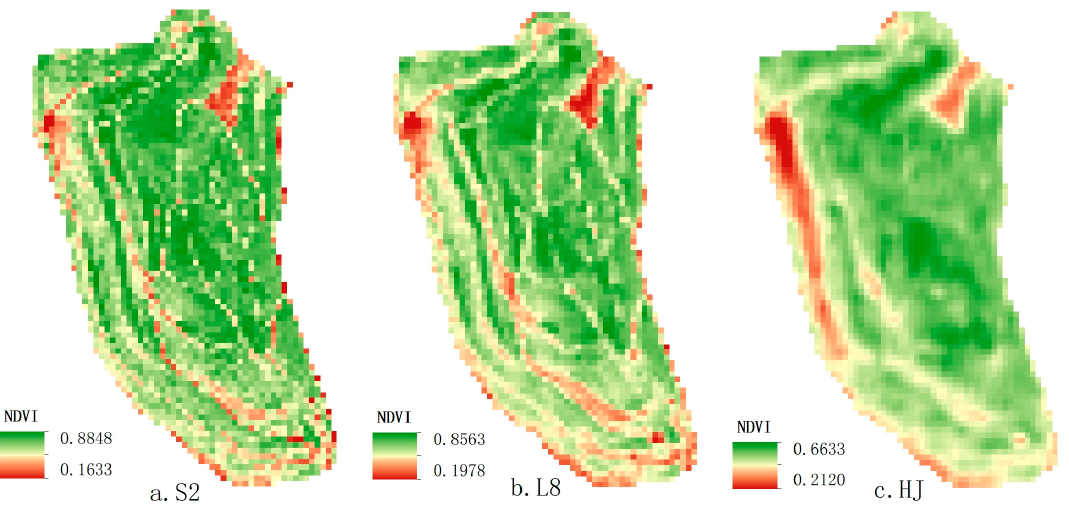
Figure 5. NDVI monitored by different satellite sensors in the West Dump (( a ): NDVI caculated from Sentinel-2(S2); ( b ): NDVI caculated from Landsat 8(L8); ( c ) NDVI caculated from